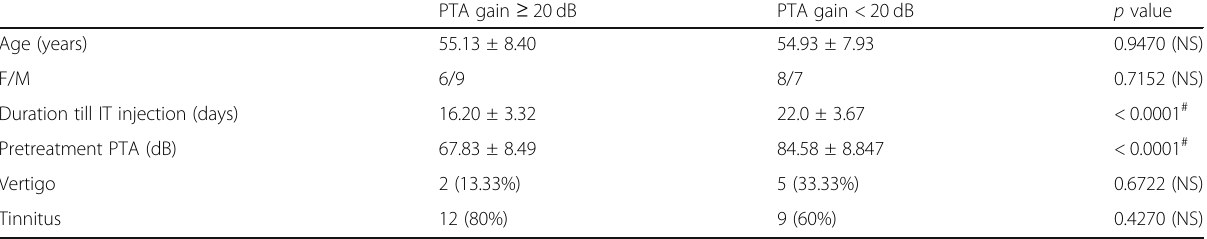
Table 3 Factors related to significant improvement of hearing (PTA gain ≥ 20